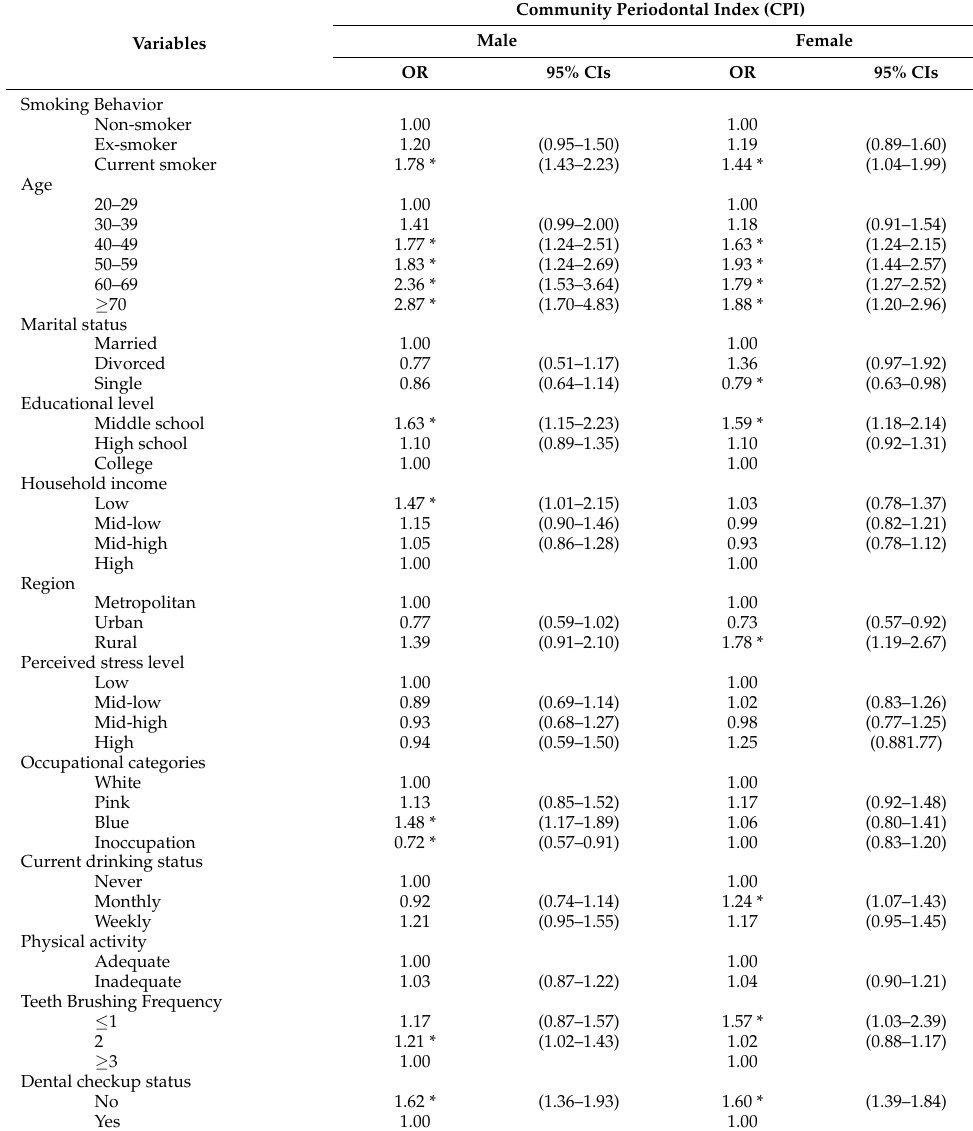
Table 2. Results of factors associated with smoking and community periodontal